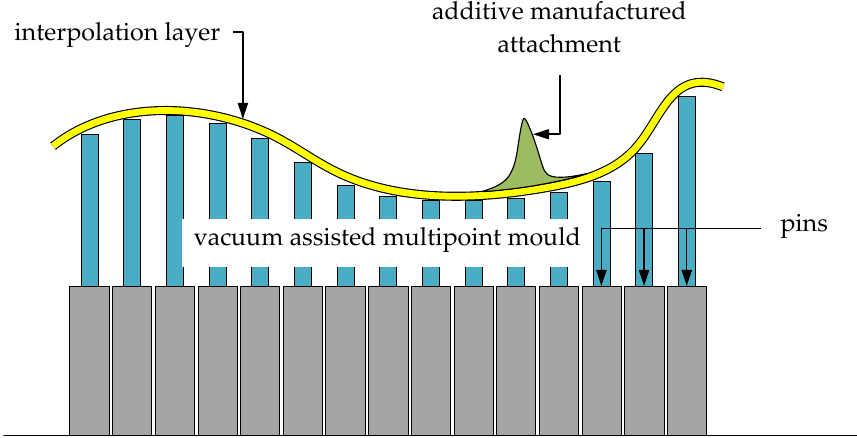
Figure 6. Enhanced vacuum-assisted multipoint moulding with additive attachments, consisting of the vacuum-assisted multipoint mould with pins and interpolation layer and the additive manufactured attachment mounted on top of the interpolation layer.